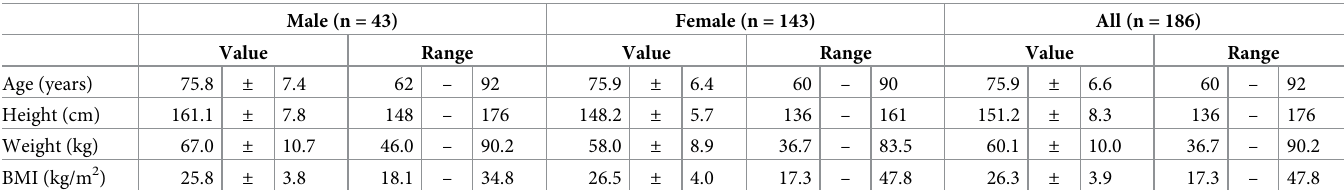
Table 1. Preoperative characteristics of the patients.